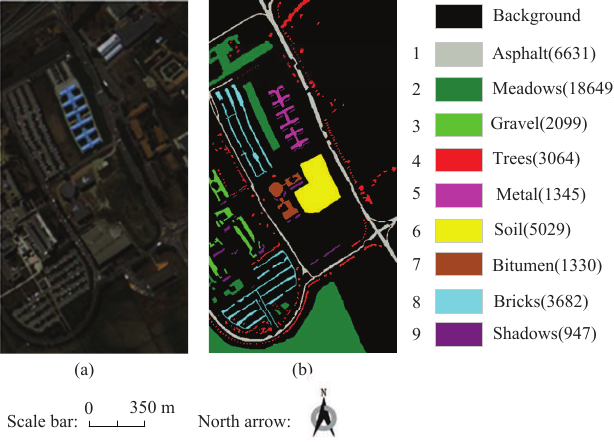
Figure 2. PaviaU hyperspectral image (HSI). ( a ) HSI in false-color; ( b ) Ground-truth map.